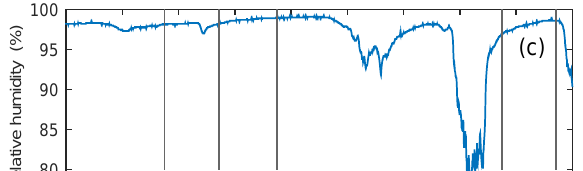
Figure 3. Position of regions of interest and helicopter thickness measurements displayed on the RADARSAT-2 scene from 31 Au- gust 2011 (R2). The polarimetric image is a Pauli composite, the intensity channel combinations | HH − VV | , 2 | HV | and | HH + VV | are assigned to the red, green and blue (RGB) channels